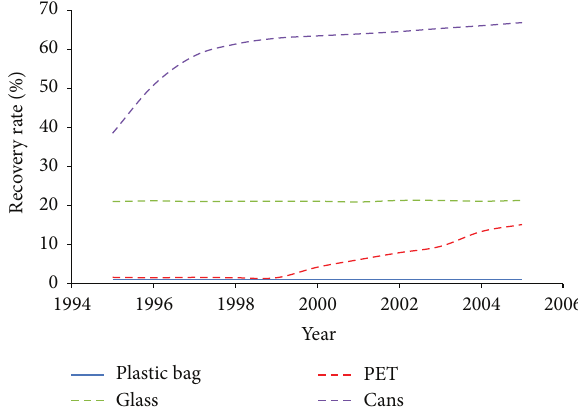
Figure 2: Recycling recovery rate of PET sources (trend of recent year) [4].